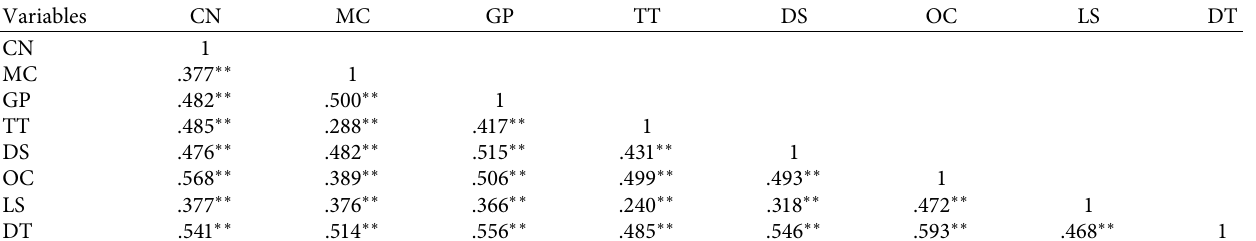
Table 8: Correlation coefficient of variables.